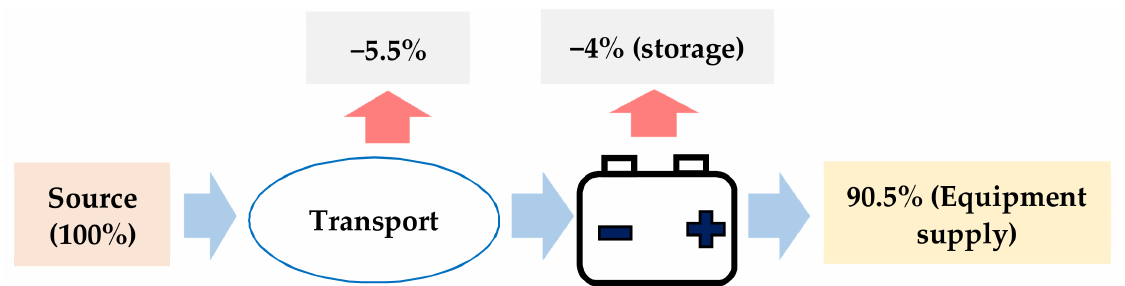
Figure 3. Electricity flow from the source to the equipment supplied considering no compensation of the transport and storage inefficiency [61].